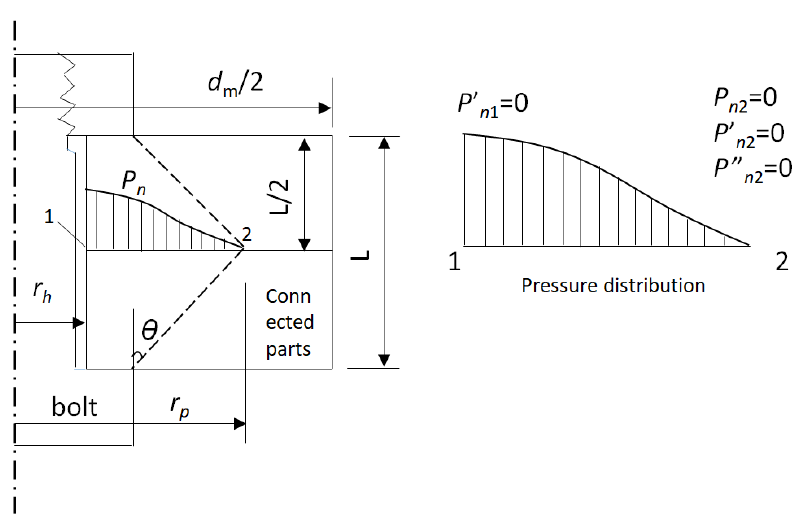
Figure 9. Assumption of contact pressure distribution of connected parts.